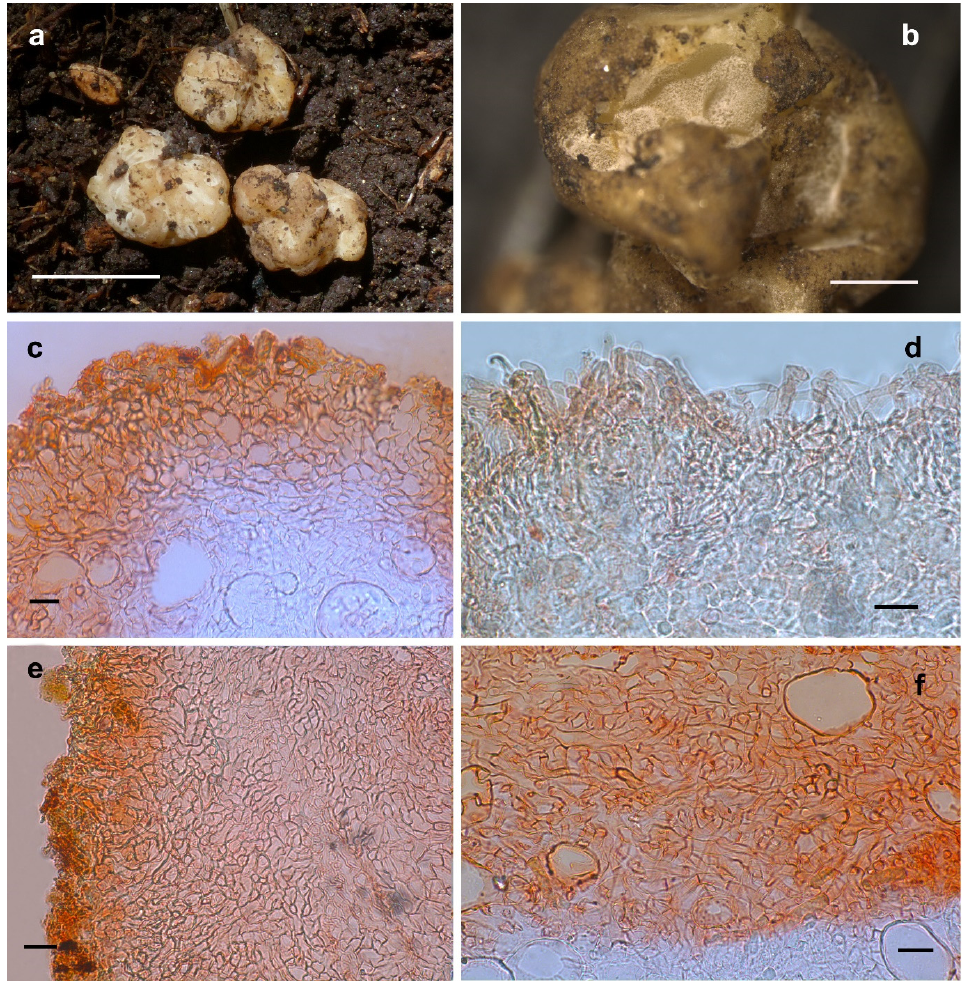
Figure 8. Hydnobolites cerebriformis (YNAU0318). ( a ) Fresh ascomata; ( b ) dried ascoma; ( c , e ) peridium; ( d ) paraphyses; ( f ) hyphae of gleba. Scale bars: a = 1 cm; b = 1 mm; c–f = 20 µm.